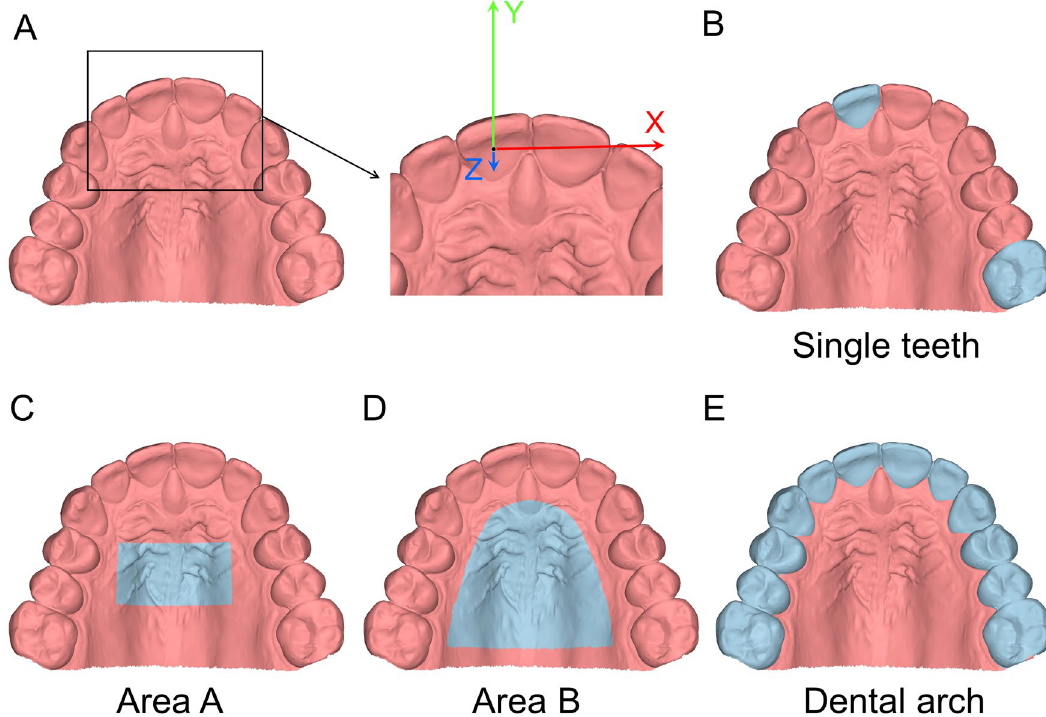
Figure 1. 3D model and reference areas used in the study. ( A ) The whole 3D model cropped within 1 mm from the buccal sulcus and distal to the first molar. The black square indicates the area magnified at the right side, showing the axes of movement and rotation, positioned on the crown centroid of upper right central incisor. X-axis: red, lateral movement (positive: left). Y-axis: green, anteroposterior movement (positive: anterior). Z-axis: blue, vertical movement; positive: down). ( B ) Clinical crown of a randomly selected central incisor and the first molar of the contralateral quadrant (light blue). ( C ) Area A including the medial 2/3 of the second and the third rugae and the area 5 mm dorsal to them (light blue). ( D ) Area B including almost the whole palate, delimited by a line 5 mm distant from the gingival margin and extending posteriorly until the middle of the first permanent molars (light blue). ( E ) The dental arch area including all maxillary teeth till the first molars (light blue). All images were generated using Viewbox 4 software (version 4.1.0.1 BETA, http:// www. dhal. com/ viewb oxind ex.